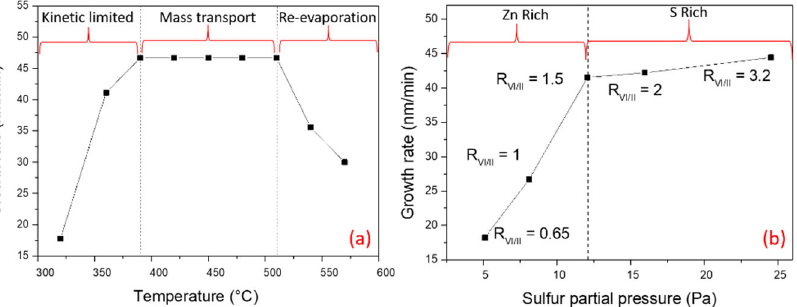
Figure 1. Growth rate of ZnS thin films as a function of: ( a ) substrate temperature, and ( b ) DTBS partial pressure.